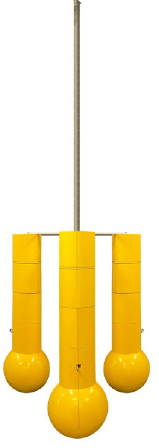
Figure 2. Picture of the Sphere Model.